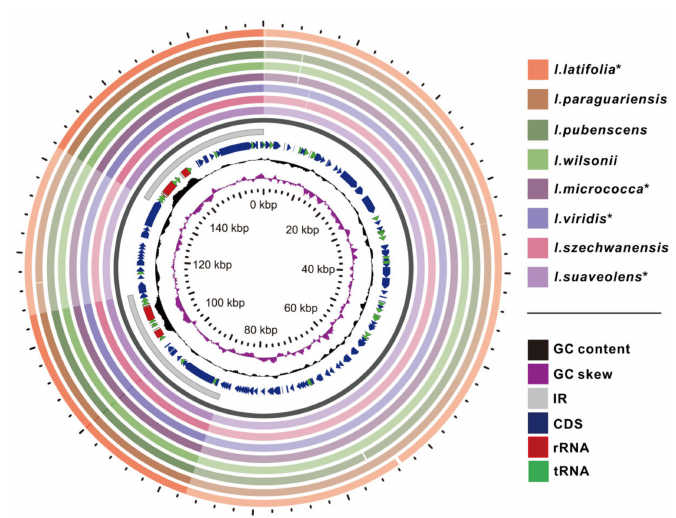
Figure 3. Plastome comparison between eight Ilex species in GView. The eight outer circles represent the BLAST results for I. suaveolens vs. I. latifolia , I. paraguariensis , I. pubescens , I. wilsonii , I. micrococca , I. viridis , I. szechwanensis , and itself, respectively. The clockwise inner cycle shows the CDS, ribosomal RNA (rRNA) genes, and transfer RNA (tRNA) genes in the plastome of I. suaveolens . The GC skew in a purple color indicates either G > C or G < C, and the GC content is shown in black.